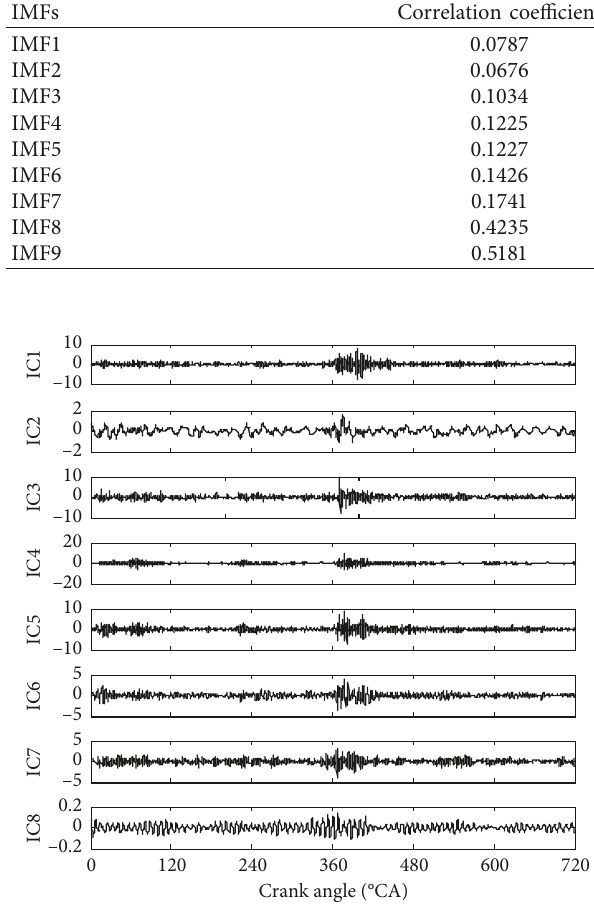
Crank angle Figure 13: The calculation results by the RobustICA